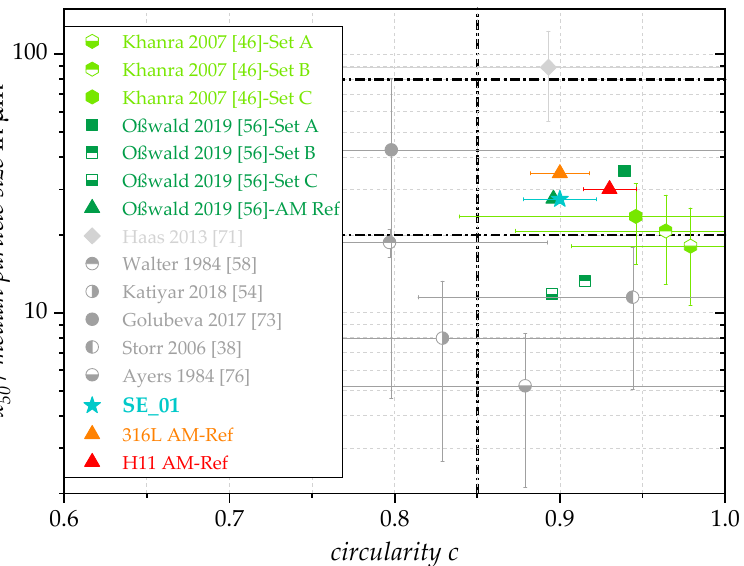
Figure 5. x 50,3 values against circularity values for 13 particle systems out of the literature compared to AM reference materials (316L/1.4404 + H11/1.2343) and die-sink EDM waste (SE_01). Data from